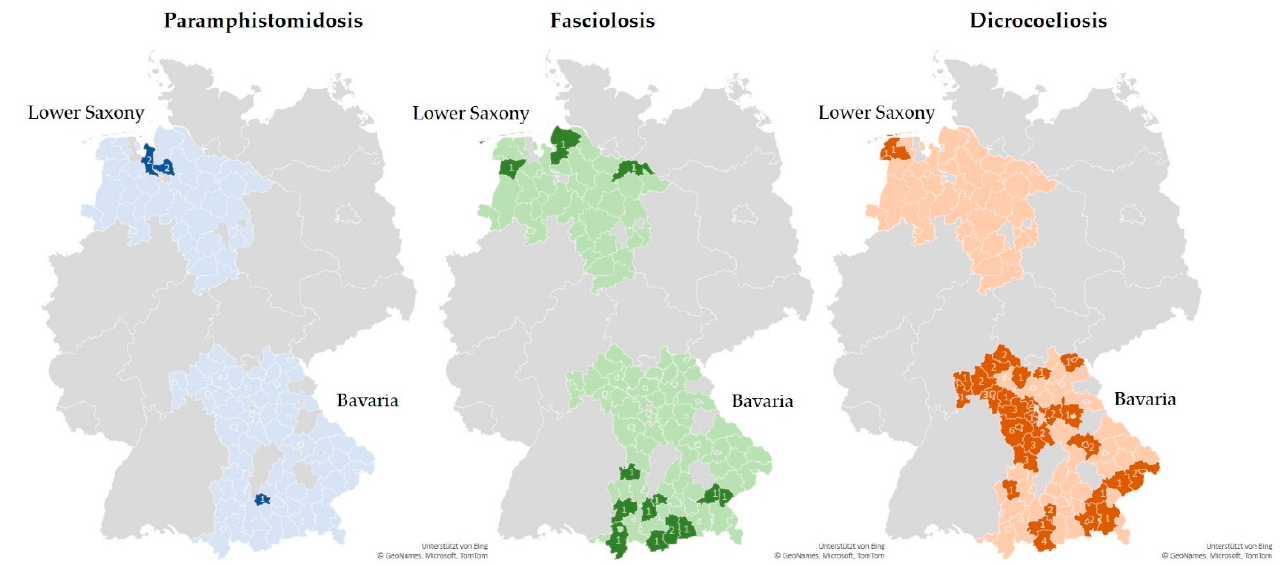
Figure 3. Distribution and numbers of rumen fluke, F. hepatica , and D. dendriticum -positive sheep farms and goat farms by administrative district within the federal states of Bavaria and Lower Saxony. Light color: district with sample submission(s) but no egg detection; dark color and number: district with detection of respective trematode eggs and number of positive small ruminant farms from district.